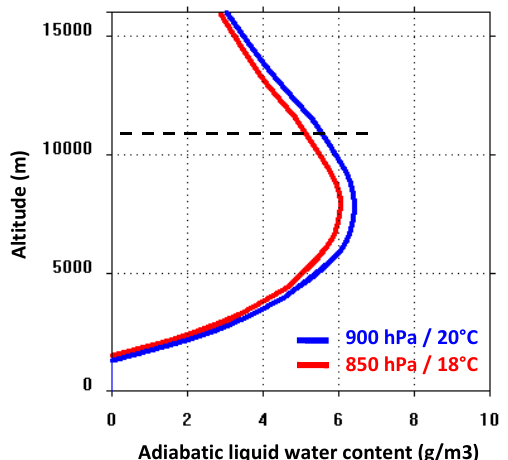
Fig. 7. Profiles of the theoretical adiabatic liquid water content (LWC), assuming the most likely thermodynamic properties of the cloud base (900hPa/20 ◦ C and 850hPa/18 ◦ C) obtained from the CALIPSO additional meteorological parameters.